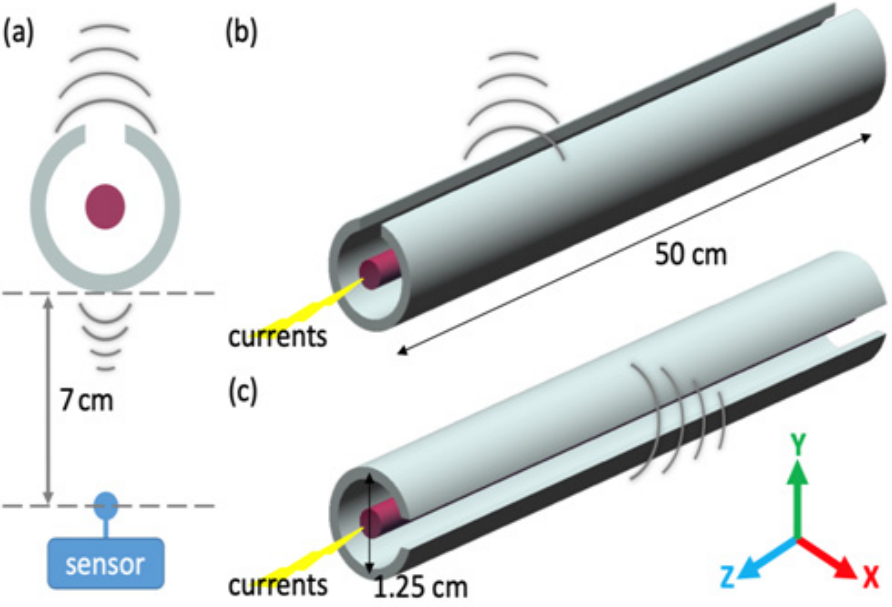
Figure 1. Measurement of the electromagnetic field in the C-shape high-permeability material. ( a ) Instrument setup. The C-opening in the vertical (i.e., the Y -axis) direction ( b ) and horizontal (i.e., the X -axis) direction ( c ). The line currents ran in the coil as indicated by the Z -axis.